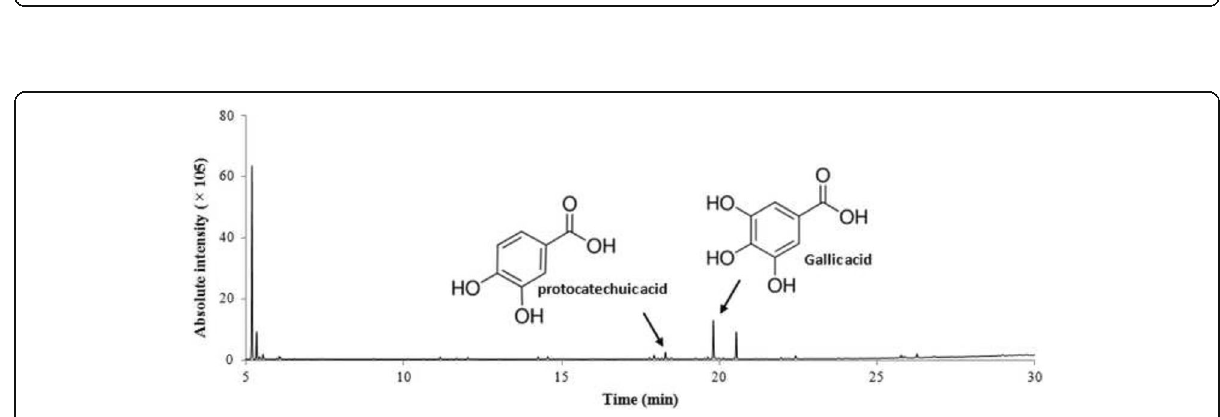
Fig. 4 Effect of ES extract on melanogenesis-related proteins expression. a B16F10 cells were cultured with α -MSH (100 nM) for 24 h and then treated with various concentration of the ES extract (8, 40, 200 μ g/ml) or arbutin (10 mM) for another 24 h. Then the content of cellular MITF, tyrosinase proteins were analyzed by western blotting assay. b Densitometry was normalized to the α -MSH group. Values are mean ± S.D. Data were analyzed by Student ’ s t-test. *: p < 0.05, **: p < 0.01 versus α -MSH treatment alone